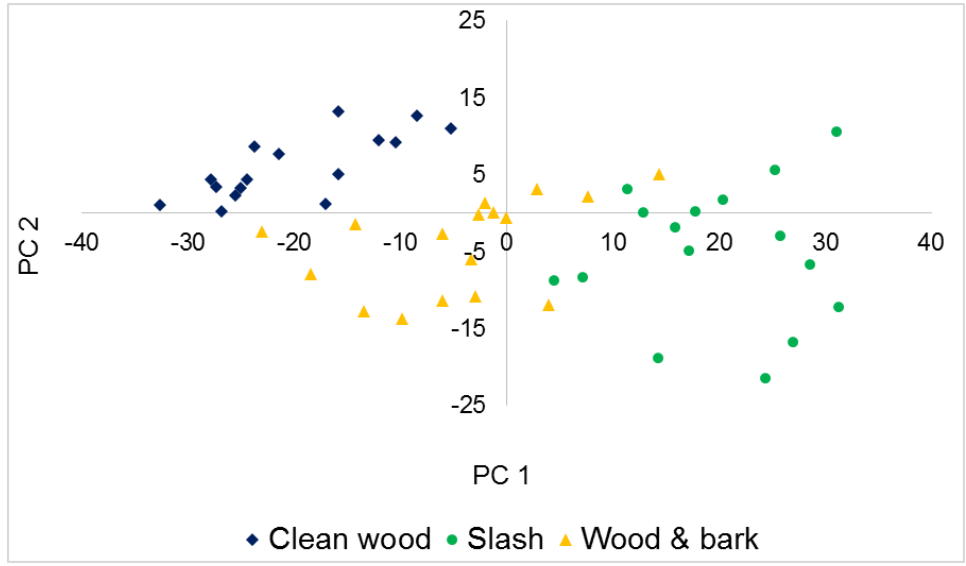
Figure 3. NIR scores plot of PC 1 versus PC 2.